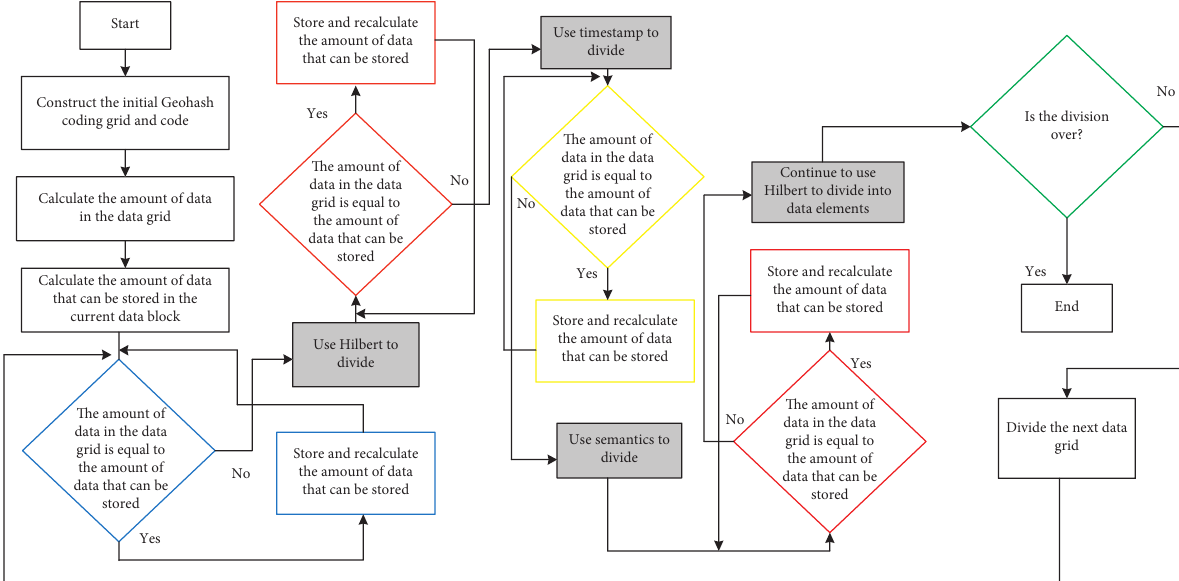
Figure 4: Flowchart of multilevel data partition algorithm based on the combination of Geohash and